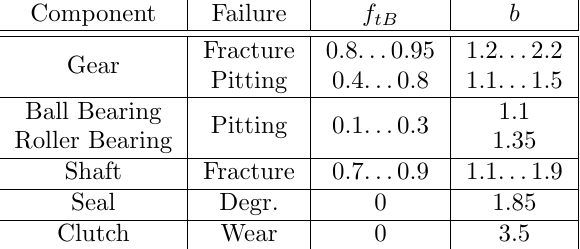
Table 1: Weibull parameters of failure distributions Bertsche and Lechner (2004)